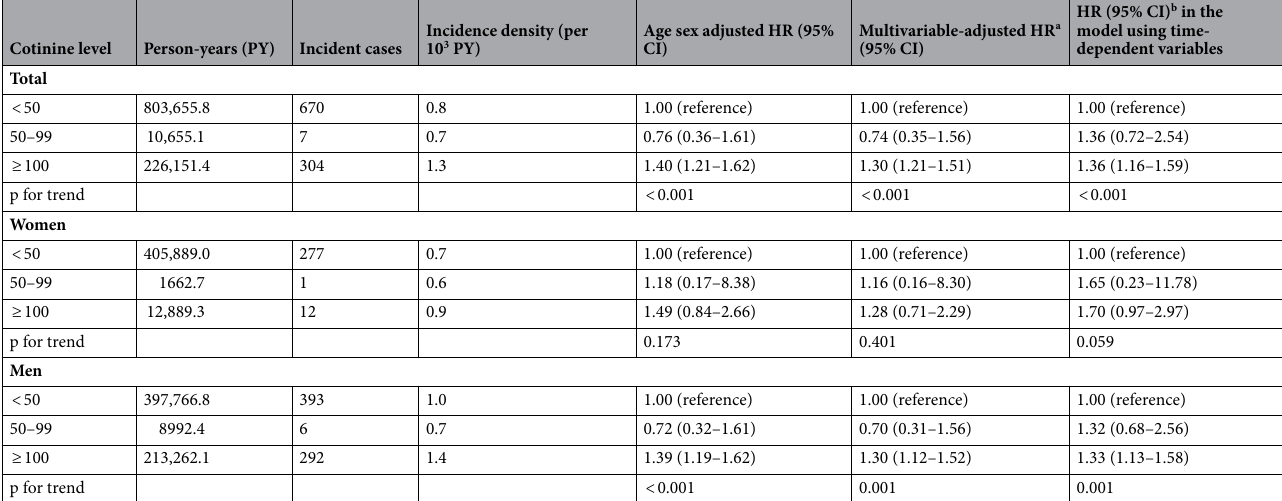
Table 3. Development of bilateral hearing loss by urinary cotinine level. The p-value for the interaction of sex and cotinine level for risk of hearing loss was 0.891. BMI body mass index, CI confidence interval, CVD cardiovascular disease, HR hazard ratio. a Estimated from parametric proportional hazards models. Multivariable model was adjusted for age, sex (only for total), center, year of screening exam, BMI, physical activity, alcohol intake, total energy intake, educational level, medication for dyslipidemia, history of CVD, history of diabetes, history of hypertension, and occupational noise exposure. b Estimated from Cox proportional hazards models with cotinine level category, physical activity, alcohol intake, total energy intake, BMI, medication for dyslipidemia, history of diabetes, history of hypertension, history of cancer, history of CVD, and occupational noise exposure as time-dependent categorical variables and baseline age, sex, center, year of screening exam, and education level as time-fixed